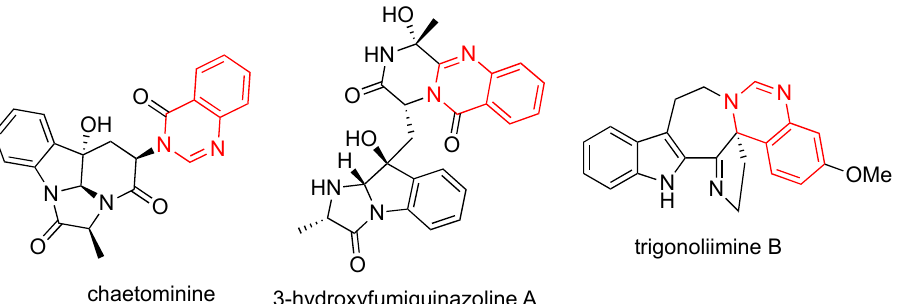
Figure 1. Biologically active natural 3,4-dihydroquinazolines.